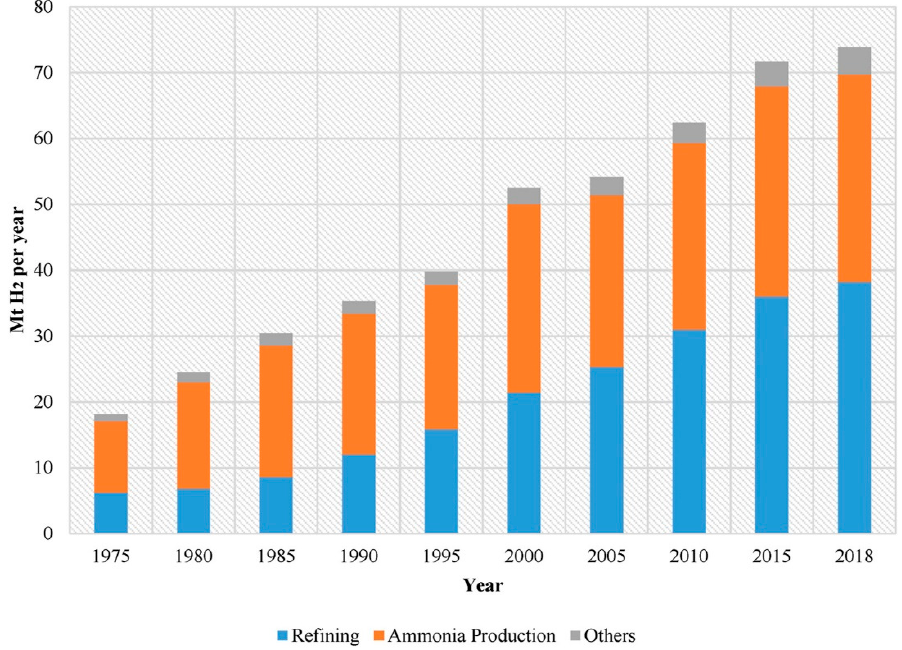
Figure 5. Hydrogen demand for the last 45 years [19]. Reprinted with permission from Elsevier.